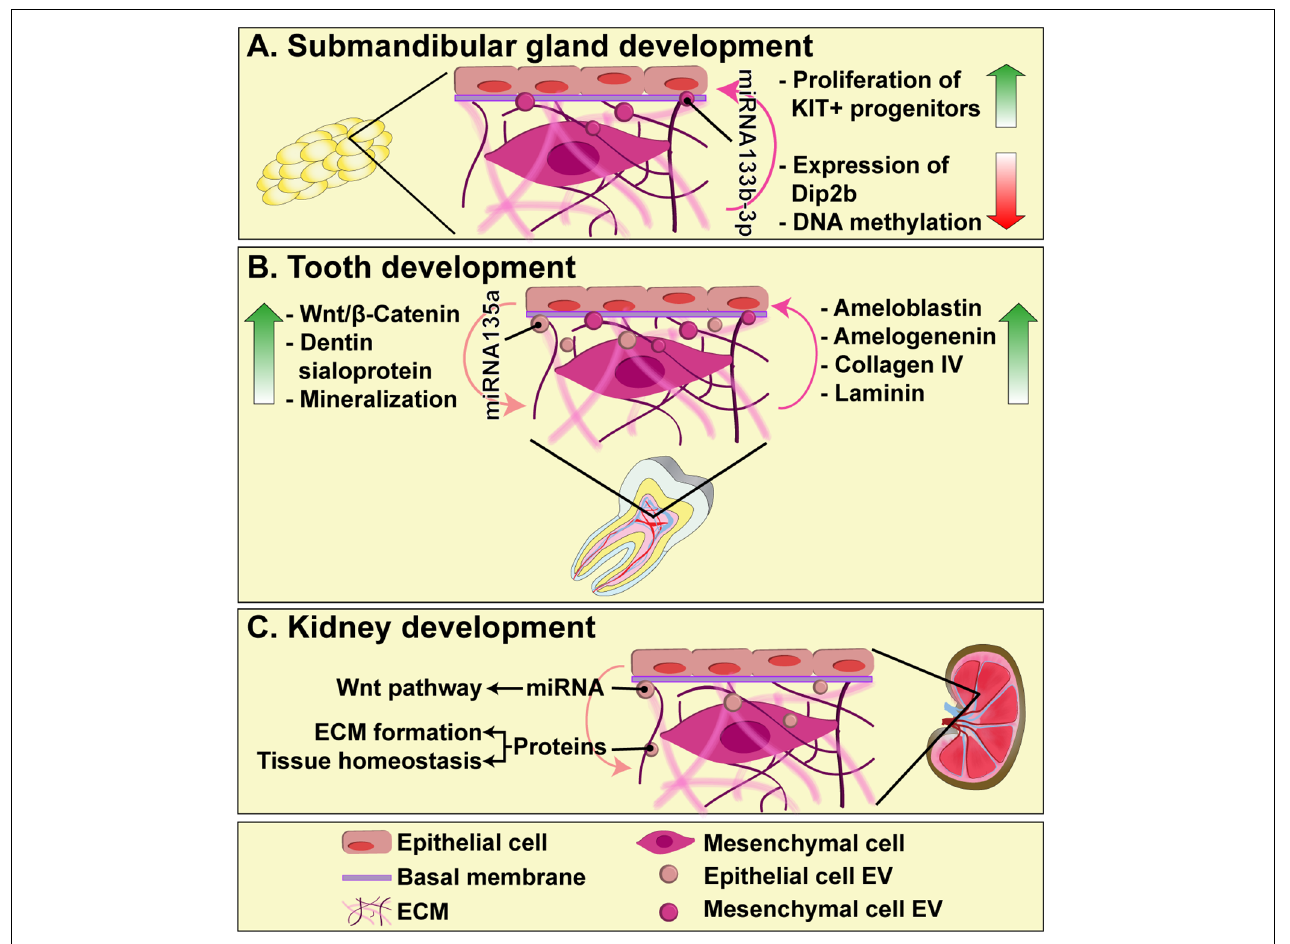
FIGURE 1 | The role of EVs in epithelial-mesenchyme interaction during submandibular gland (A) , tooth (B) , and kidney (C) development. EVs diffuse through the basal membrane and participate in intercellular communication between epithelial and mesenchymal cells, carrying proteins and miRNAs that regulate key events for organogenesis, such as cell proliferation, differentiation and ECM